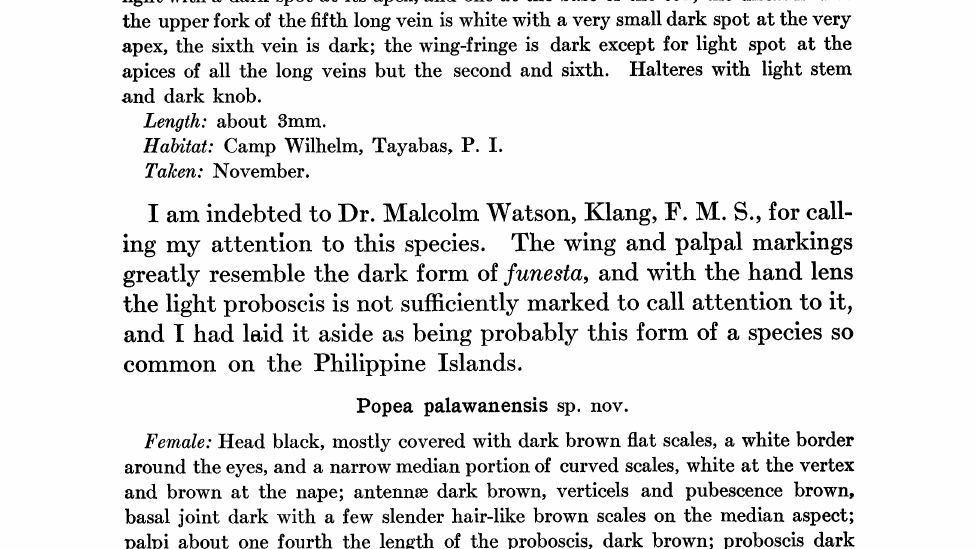
with a small dark spot at its apex and one near its base; there are light spots at the fourchette of each ford cell; the stem and lower fork of the fifth long vein are mostly light with a dark spot at its apex, and one at the base of the cell; the distal half of the upper fork of the fifth long vein is white with a very small dark spot at the very apex, the sixth vein is dark; the wing-fringe is dark except for light spot at the apices of all the long veins but the second and sixth. Halteres with light stem and dark knob.